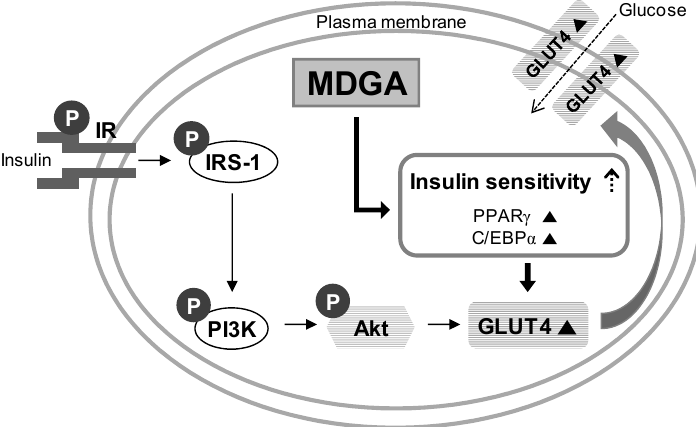
Figure 4. Proposed mechanism of MDGA for enhancement of glucose uptake. MDGA promotes adipocyte differentiation via activation of PPAR γ and C/EBP α , and leads to increase glucose uptake into adipocytes through the up-regulation of GLUT4 expression and its translocation. The symbol ▲ represents up-regulation.